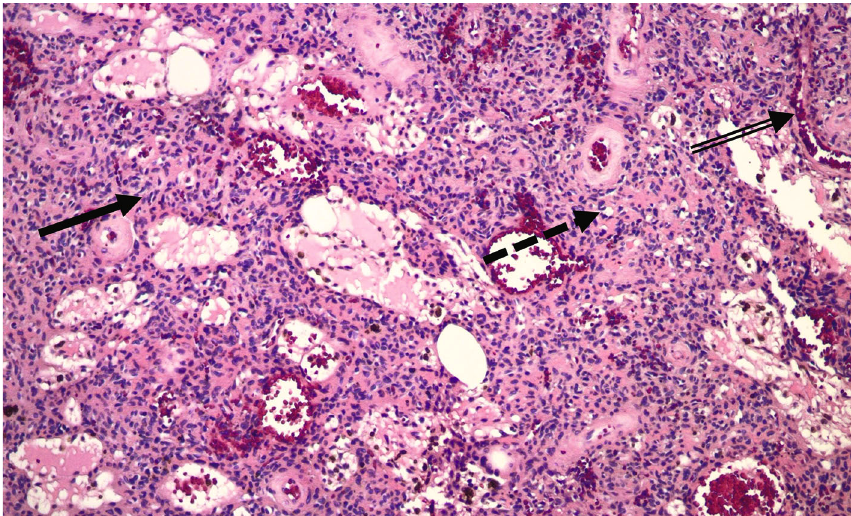
Figure 3: Photomicrograph of the specimen from Case 1. The tumor shows mitotically inactive, cytologically bland spindled to epithelioid cells arranged in a vaguely trabecular pattern (solid arrow) interspersed among hemangiopericytoma-like vessels (double arrow) and microcysts (dashed arrow) (Hematoxylin and eosin, 10 × ).